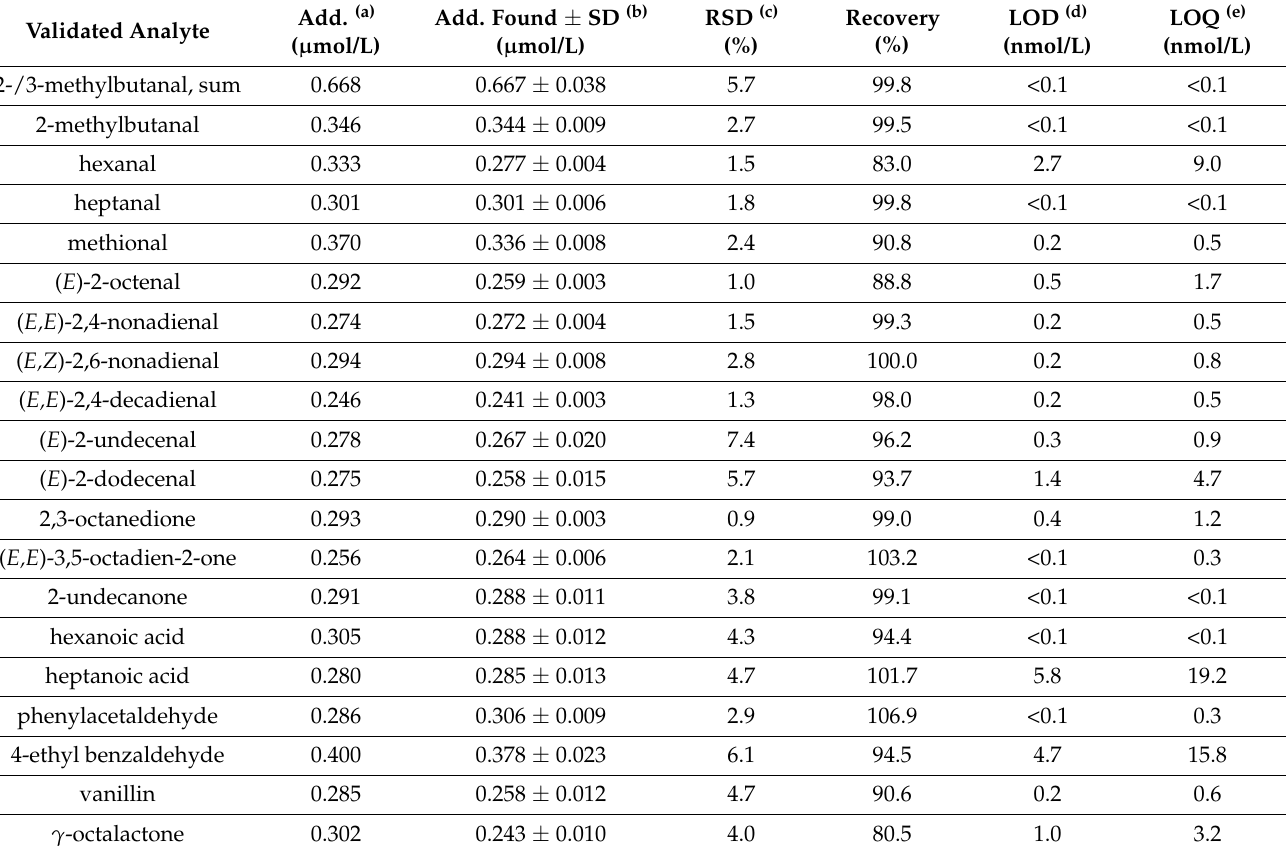
Table 2. Performed validation experiments of important odorants in pea protein